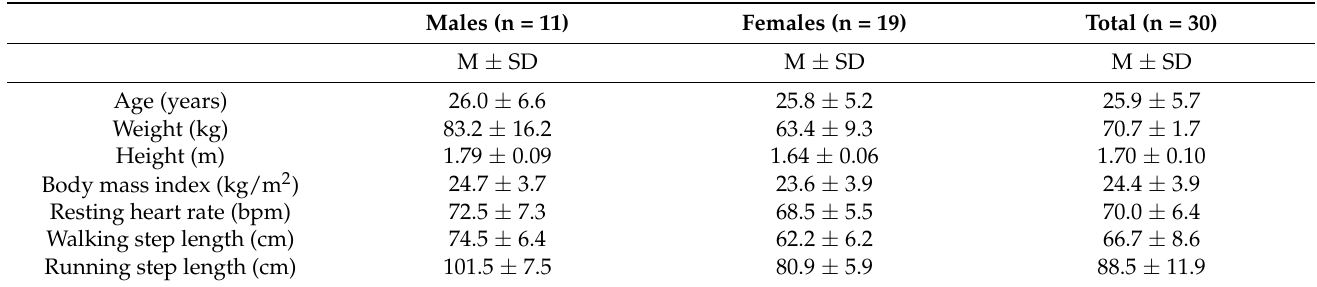
Table 1. Participants’ characteristics (Mean ±